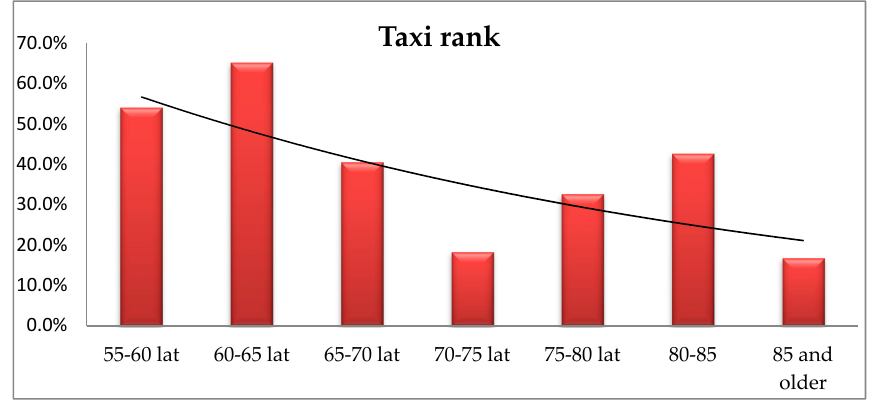
Figure 12. The respondents’ age vs. their opinion about the need of a taxi rank in their immediate environment.